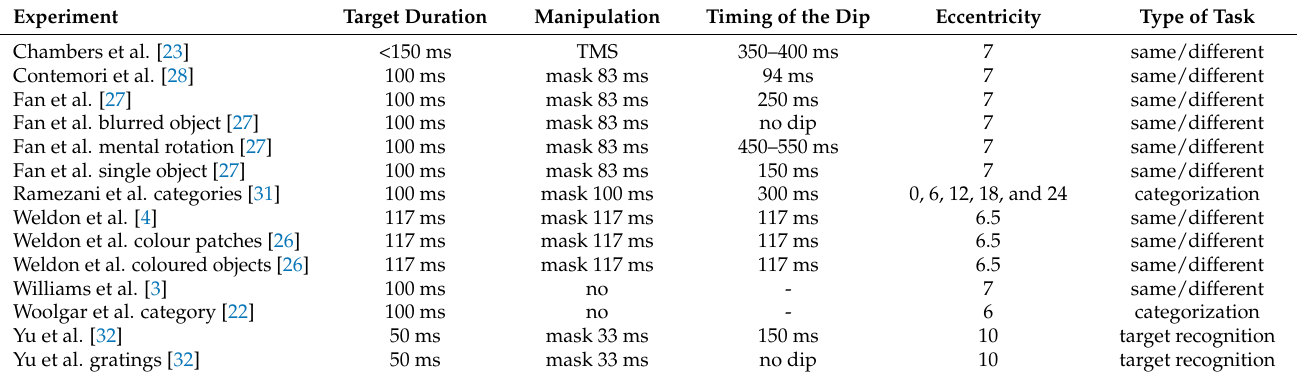
Table 1. For every study on foveal feedback with visual tasks, the following information is reported: target duration, type of foveal retinotopic cortex manipulation (TMS, mask or no manipulation for fMRI studies), timing of the dip in performance (if present and if applicable), eccentricity of the peripheral stimuli (distance from the fovea in degrees of visual angle), and the type of task performed. When nonspecified otherwise, the stimuli used in the tasks were those from